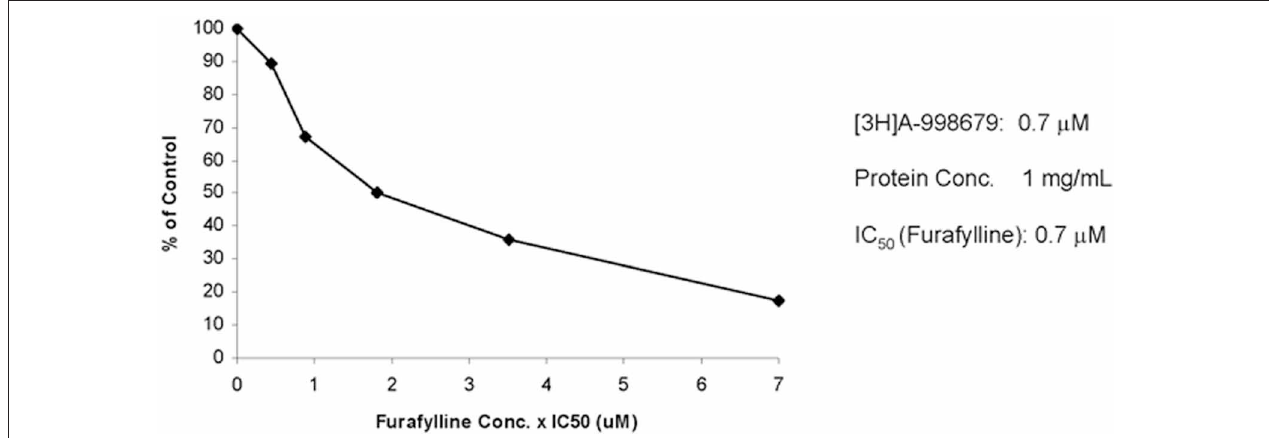
FIGURE 8 | Effect of furafylline, a specific CYP1A2 inhibitor, on the metabolism of [3H]A-998679in human liver microsomes. Incubations with radiolabeled A-998679 were conducted in duplicate in human liver